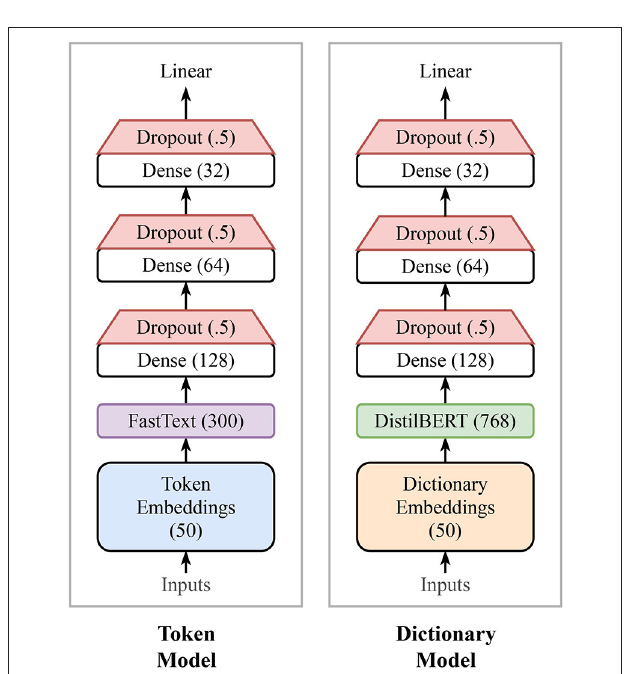
FIGURE 3 | Model architectures. Our first model is a neural network initialized with pre-trained word embeddings to estimate happiness scores. Our second model, is a deep Transformer-based model that uses word definitions to estimate their sentiment scores. See section 3.2 and 3.3 for further technical details of each model, respectively. Note the Token model is considerably smaller with roughly 10 million trainable parameters compared with the Dictionary model that has a little over 66 million parameters.